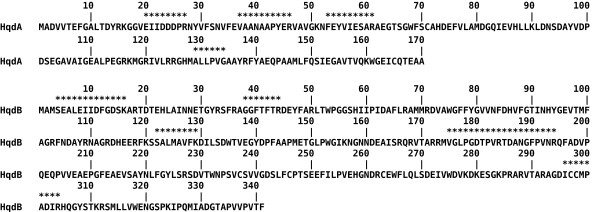
Amino acid sequences deduced from open reading frames found in a part of genomic DNA from Sphingomonas sp. strain TTNP3. The amino acids marked with asterisks were identified by nanoHPLC-nanoESI-MS/MS (from residues 175 to 194, two peptides were matched, one ranging from 175 to 184, the other one from 185 to 194).